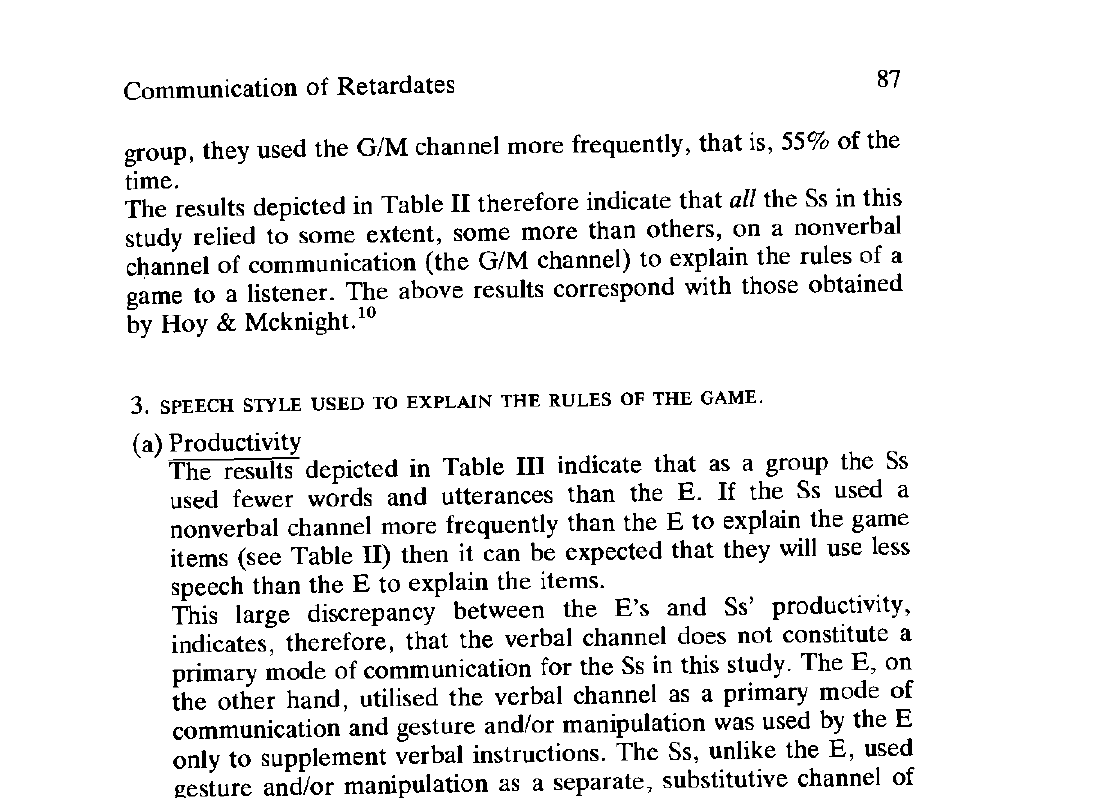
TABLE III: A comparison between the productivity of the Ε and Ss. Number of Number of words